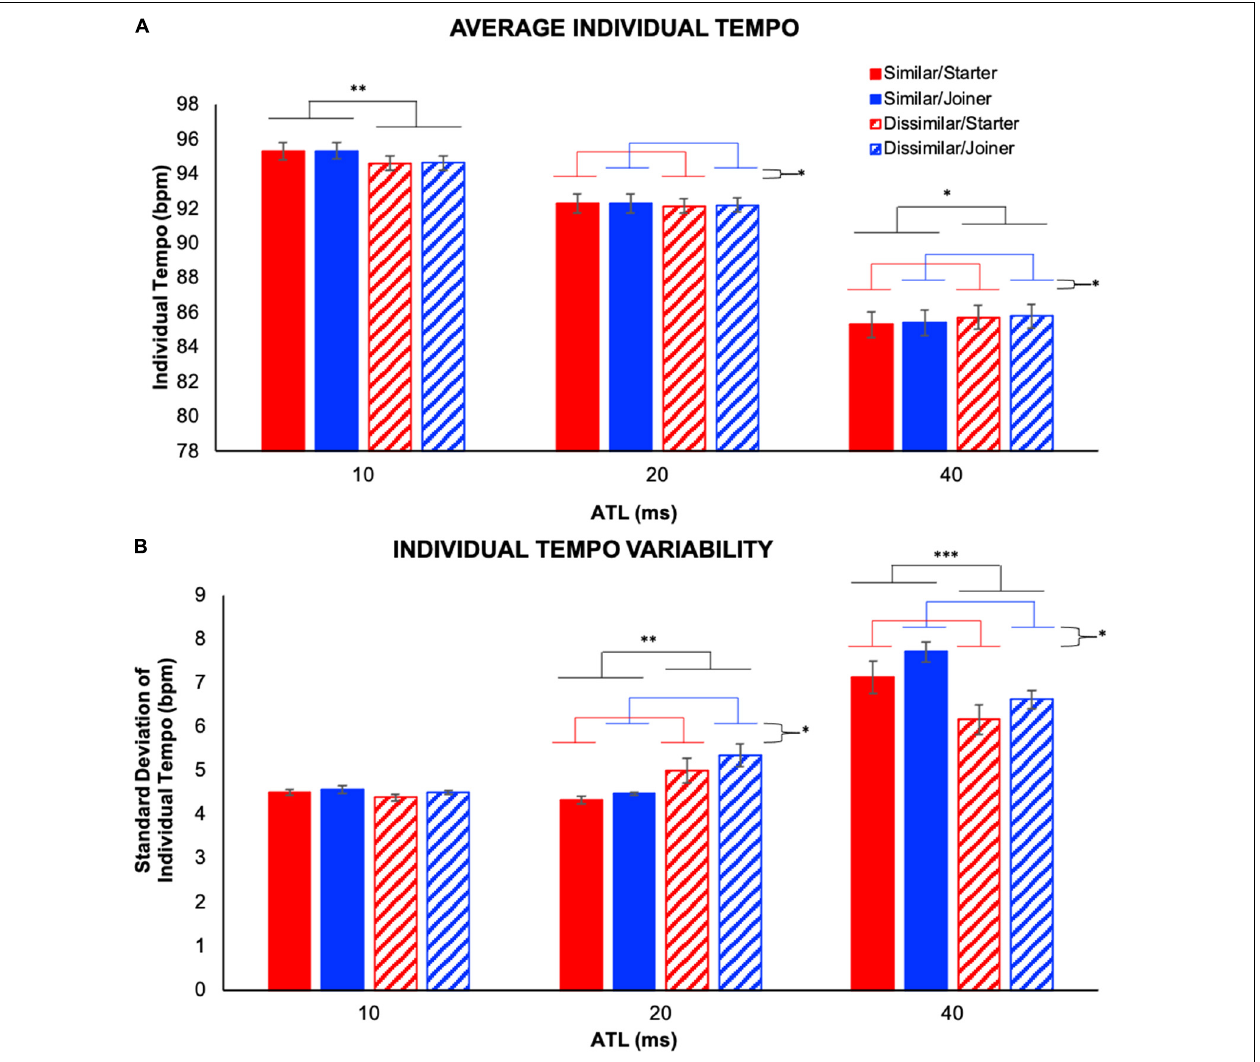
FIGURE 5 | Individual temporal behavior. (A) Average individual tempo illustrates the tempo produced by each individual averaged over the trials. Note that the 10- and 20-ms ATL resulted in a faster tempo than the initial tempo (90 bpm on average) whereas the 40-ms ATL made performers play slower. (B) Individual tempo variability is computed as the standard deviation of each individual’s tempo values over the course of a trial. Significant interactions were observed between part similarity and ATL, as well as between performer role and ATL for average individual tempo (A) , and individual tempo variability (B) . Error bars show standard